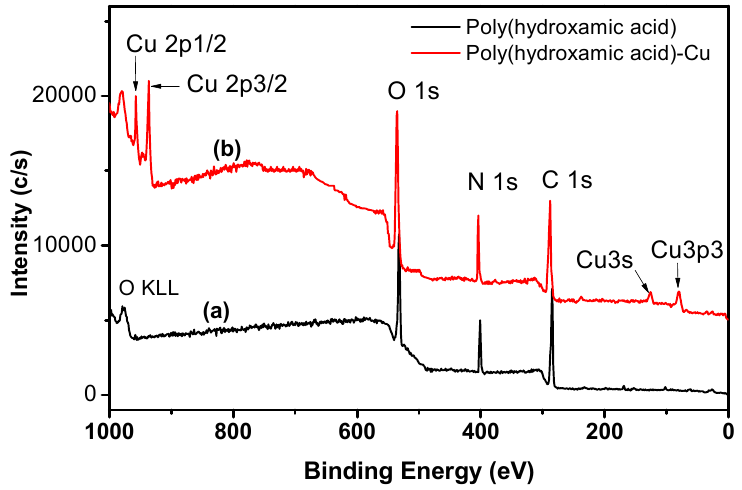
Figure 5. XPS spectra of ( a ) poly(hydroxamic acid) ligand and ( b ) poly(hydroxamic acid)-Cu(II).